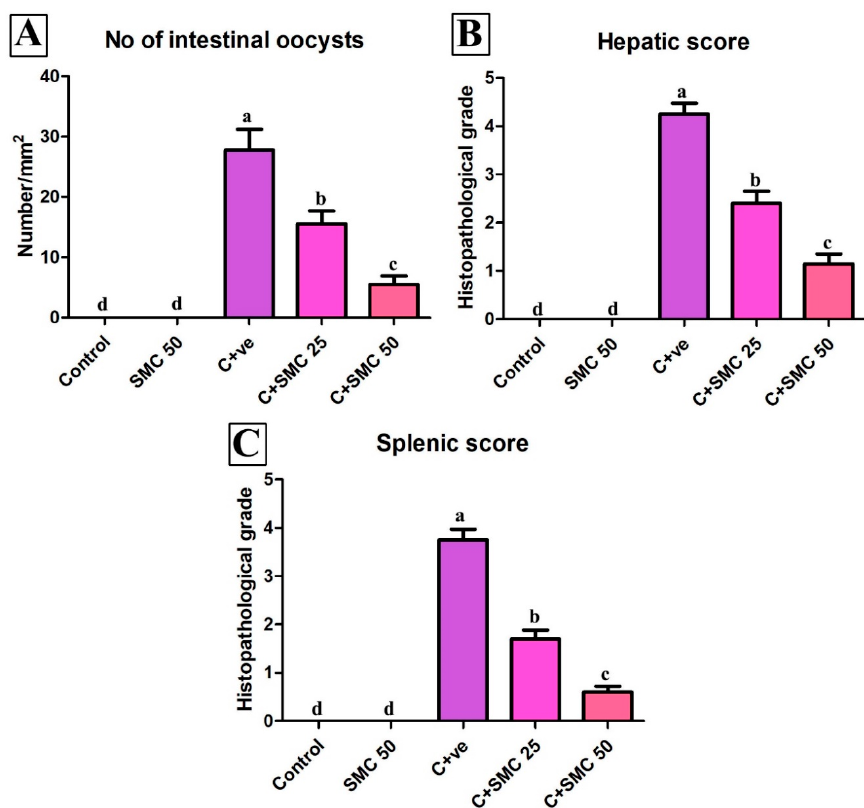
Figure 6. Quantitative scoring of intestinal oocyst count ( A ), hepatic ( B ), and splenic ( C ) lesions. Data were expressed as mean ± S.D. Each bar carrying different letters (a, b, c) is significantly different ( p < 0.05). Biomedicines 2020 , 8 , x FOR PEER REVIEW